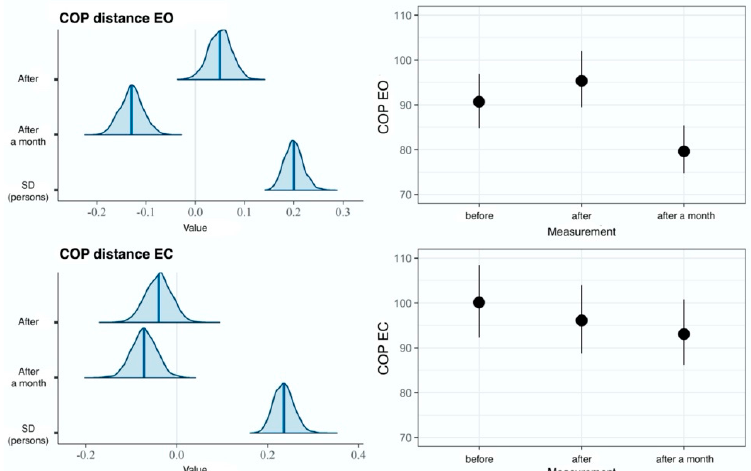
Figure 4. Results of hierarchical two-dimensional regression analysis: the dependent variable is the COP distance, and the main effect is the measurement in the experimental group. Left panels: a posteriori distributions of regression coefficients. Shaded areas denote 95% confidence level. Right panels: estimated marginal means. The points denote a posteriori distribution mean values, and vertical lines represent 95% confidence intervals. COP—center of pressure; EO—eyes open; EC—eyes closed.